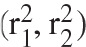
Similar to Figure 1, but now using the expressions for ϕij given by Eqs. (26-27) and Eqs. (32-33) obtained by propagating fr1,r2=ς2maxr12r22 of Tremaine (1998) and ℱ(r1, r2) = ς r1r2 of Teyssandier & Ogilvie (2016), respectively, through the general framework outlined in Appendix A. Shown as a function of softening ς are ψ1 (panel A) and ψ2 (panel B) for two PL disc models specified by p and q indicated in panel A. Black lines represent the expectations based on Silsbee & Rafikov (2015), to which the new expressions for ψ1 and ψ2 successfully converge as ς → 0.